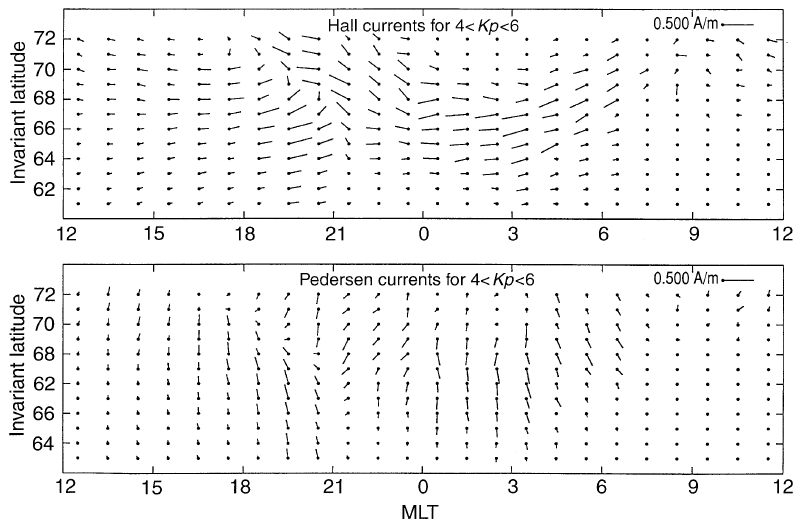
Fig. 8. Statistical distributions for Kp " 4 — 6 of Pedersen and Hall